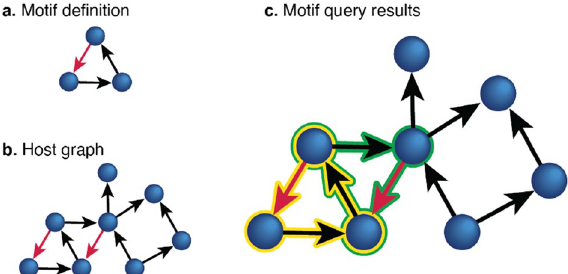
Figure 1. Subgraph search. Subgraph search is formally defined in “Background” section. ( a ) A motif query is defined. In this example, the query is a simple directed triangle. One edge (red) has been assigned an attribute constraint (perhaps a neurotransmitter type or weight threshold). ( b ) A directed search graph, or “host” graph. Two edges in the host graph share the same attribute as the constrained edge in the motif. ( c ) The motif is discovered in the search graph. Two unique detections are shown here, highlighted in yellow and green. Note that edges and nodes in the host graph may appear in more than one